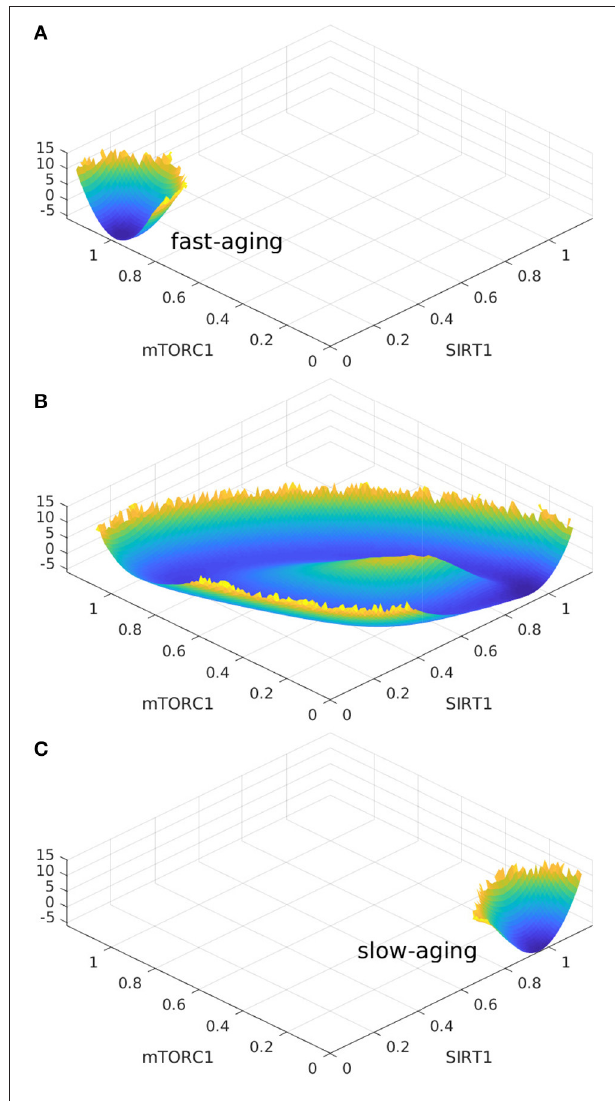
FIGURE 7 | The landscape topography changes from the monostable state of fast-aging to the oscillation between the fast-aging and the slow-aging, and then to the monostable slow-aging state upon the increase of the regulation of Sestrins->AMPK. (A) The landscape of fast-aging. (B) The landscape of oscillation between fast-aging and slow-aging. (C) The landscape of